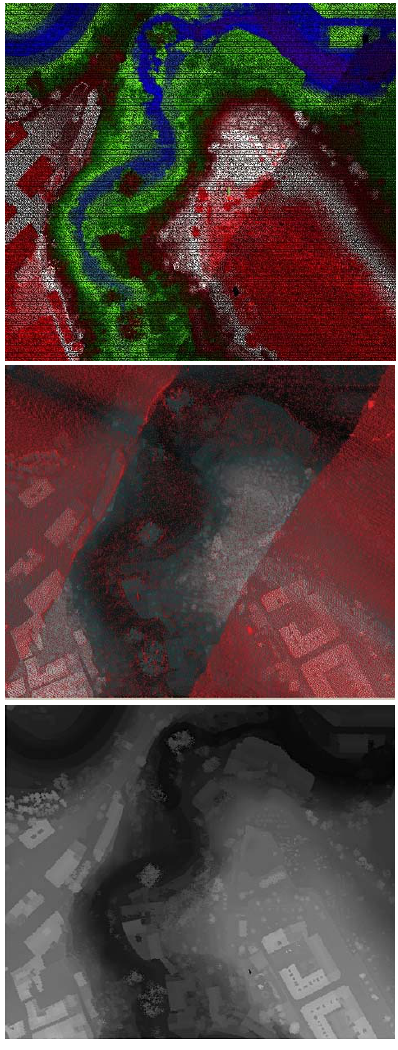
Figure 1. Regular grid generation process. Upper: original data; Middle: Initial regular grid generation –red pixels representing no data grids-; Lower: Final regular grid.